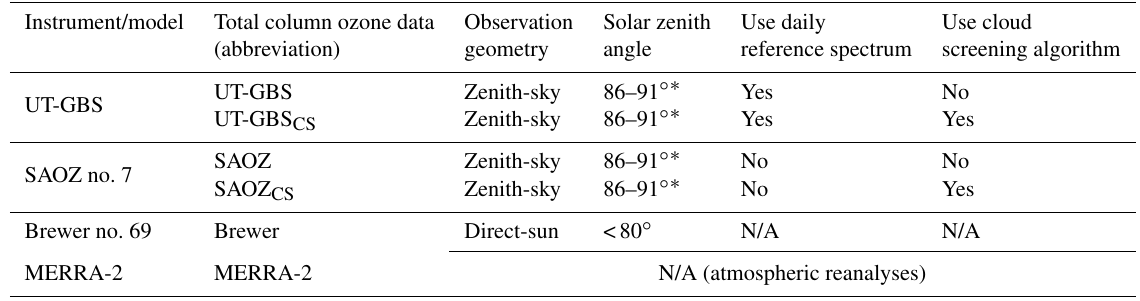
Table 1. Summary of measured and model ozone data products. N/A denotes not applicable.